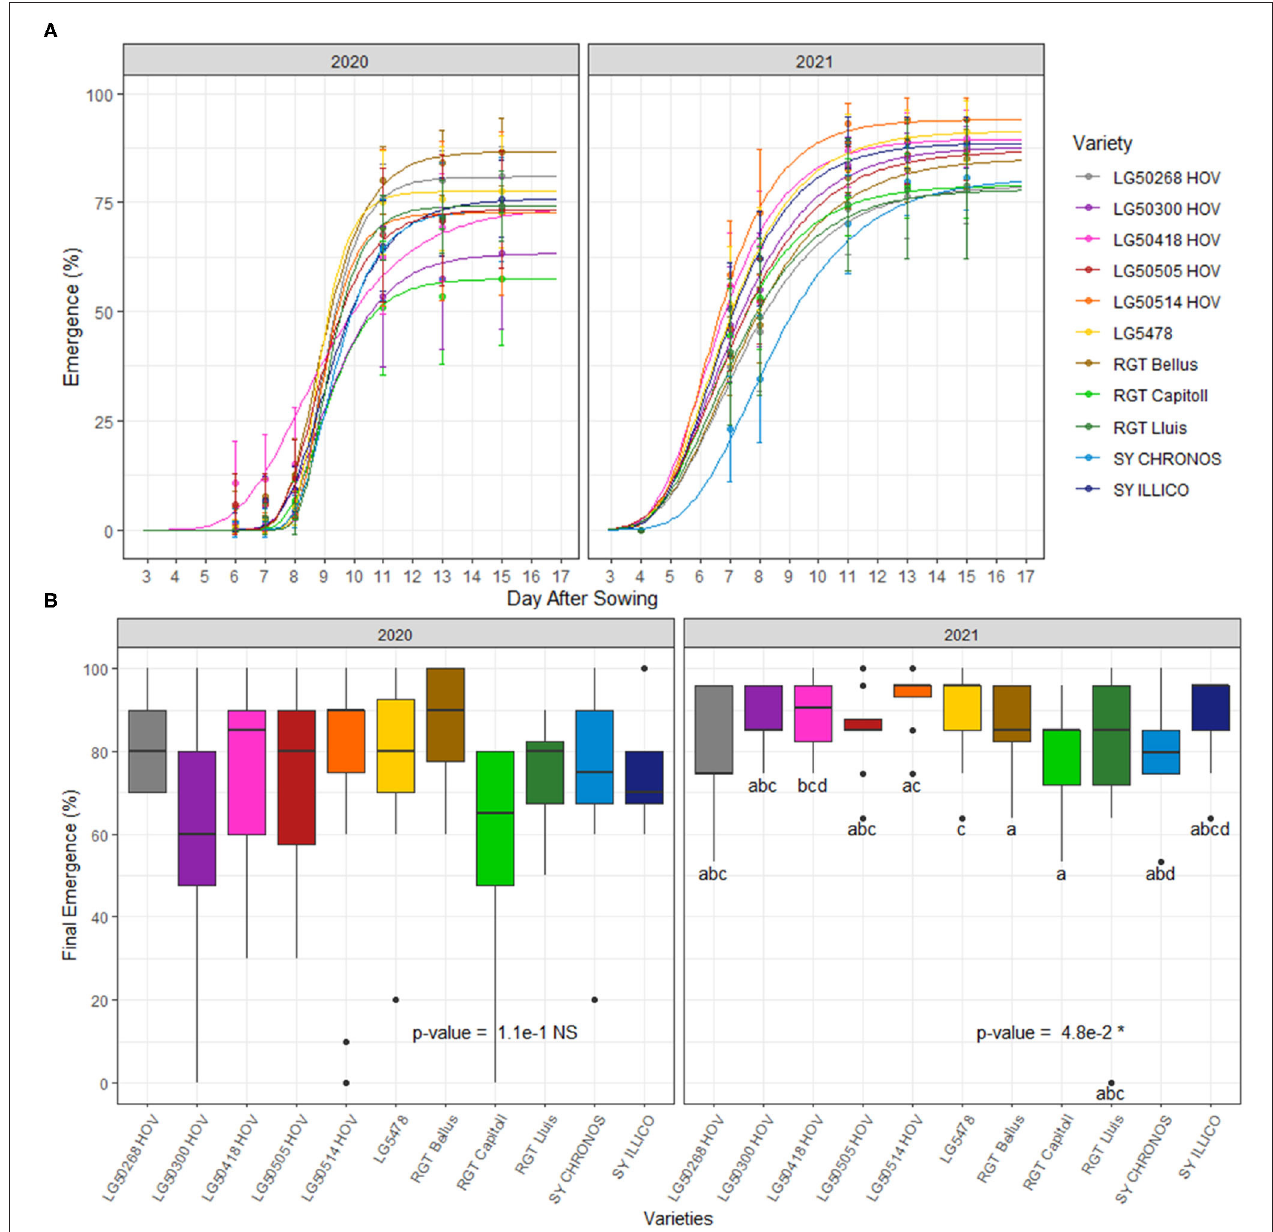
FIGURE 6 | Emergence dynamics (A) and final rates (B) of 11 hybrid oilseed varieties of sunflower over the two experimental years, 2020 and 2021 at the Auzeville experimental station. Vertical bars reported in the figure represent confidence intervals. The different letters indicate a significant difference between the tested varieties.